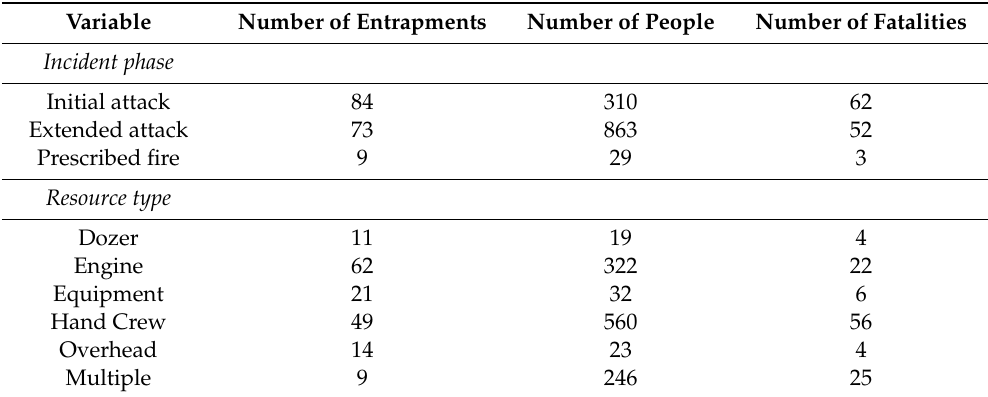
Table 3. Summary of US wildland firefighter entrapments that occurred within CONUS (1981–2017) by incident phase and type of resource